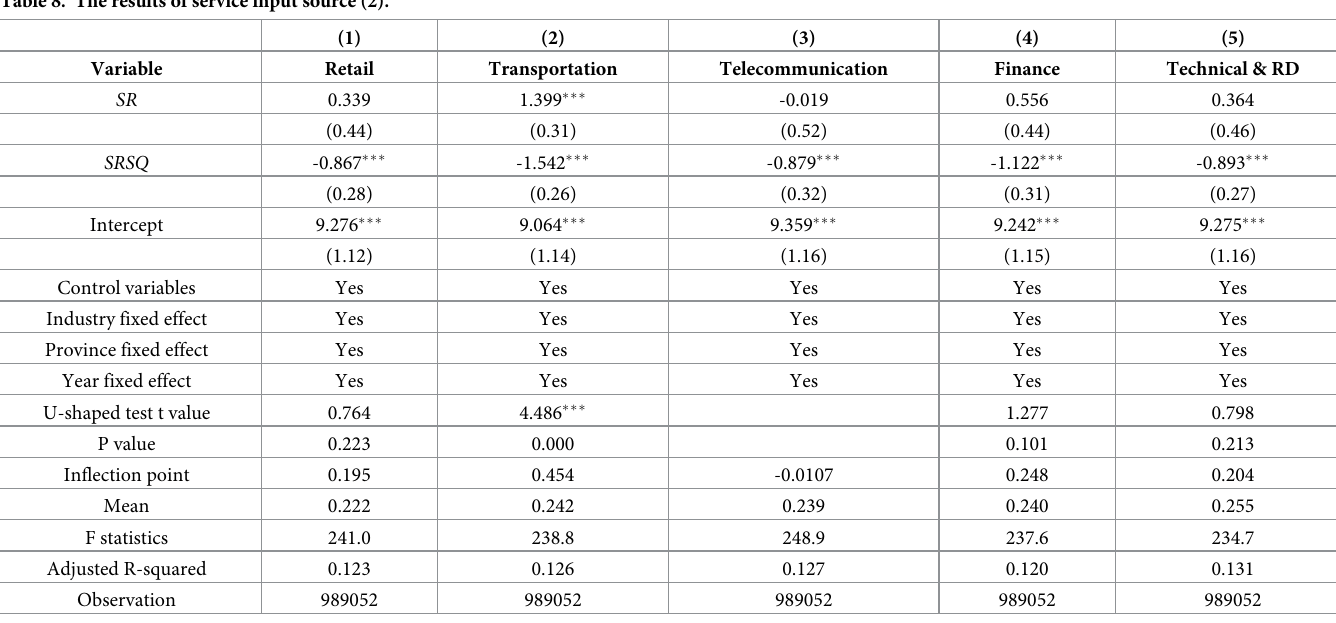
Table 8. The results of service input source